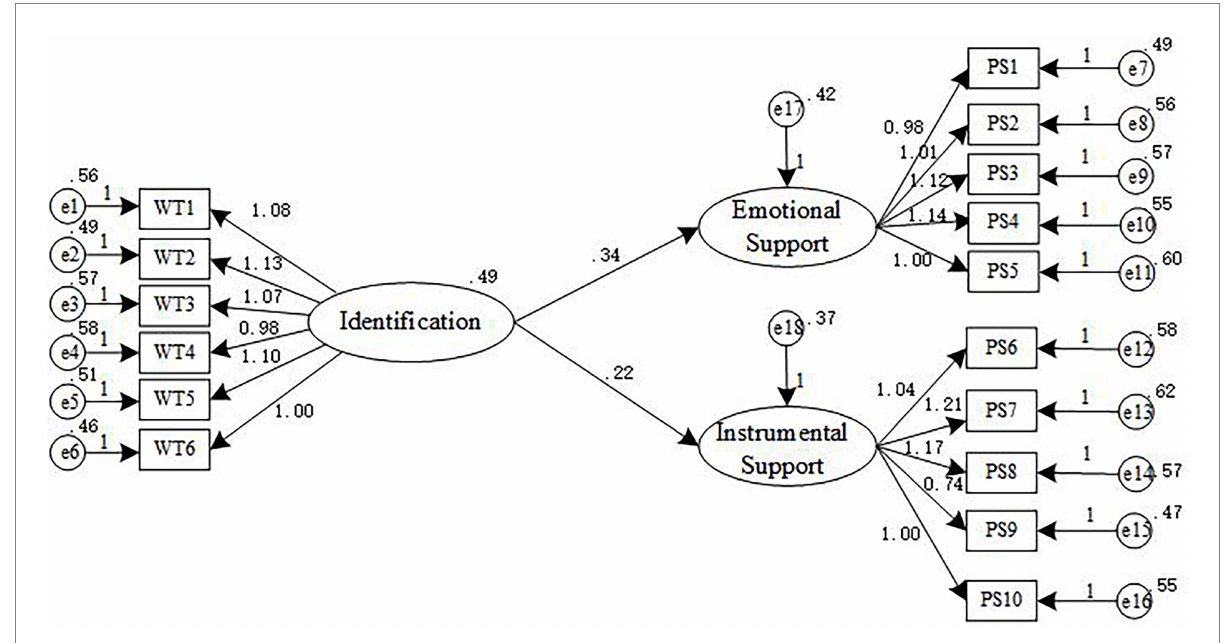
FIGURE 3 Relationship between identification and family business support.